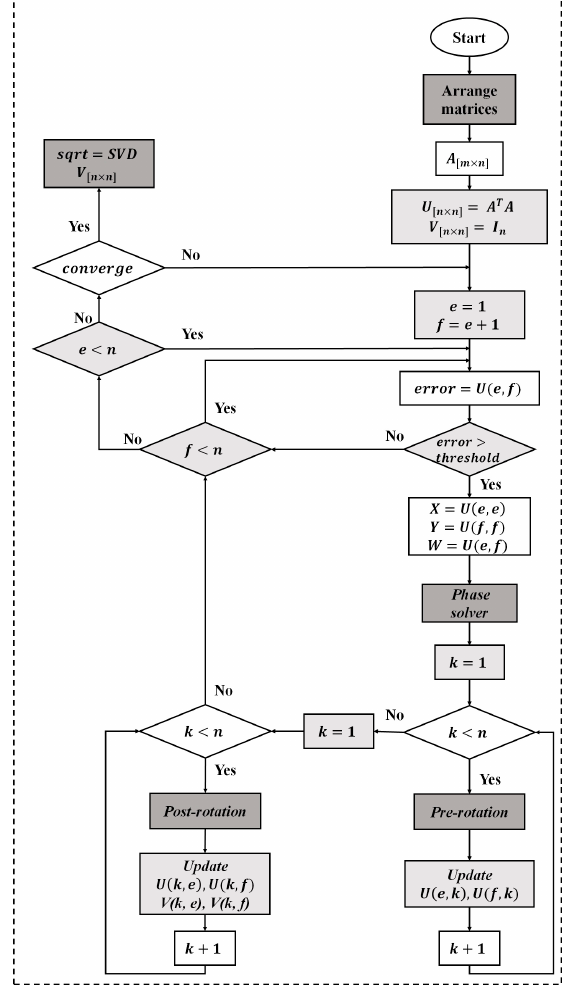
Figure 5. Flow diagram of the singular value decomposition implementation.